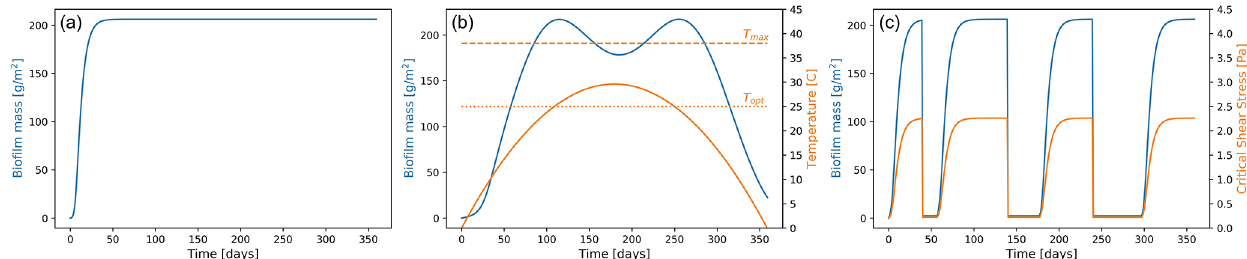
Figure 2. Biofilm development over time. Biofilm growth patterns in cases of (a) annual undisturbed growth following the logistic growth function, (b) growth affected by the variation in sediment temperature due to seasonality over a year-long simulation, and (c) growth affected by carpet-like